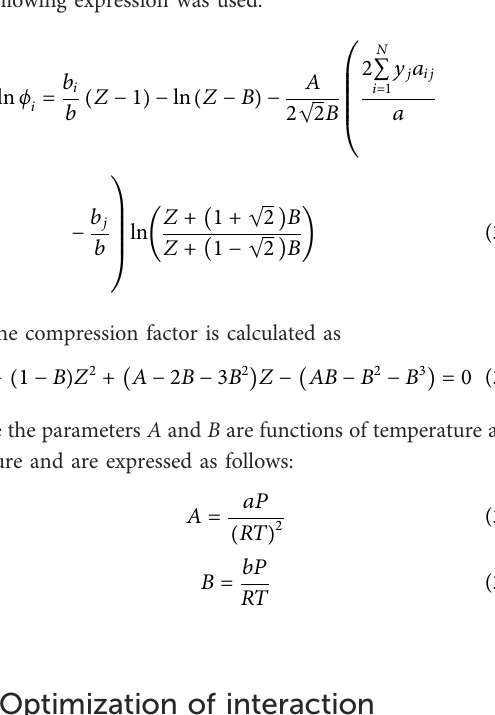
FIGURE 1 Variation in theinteraction parameters of CH 4 and water with temperature and